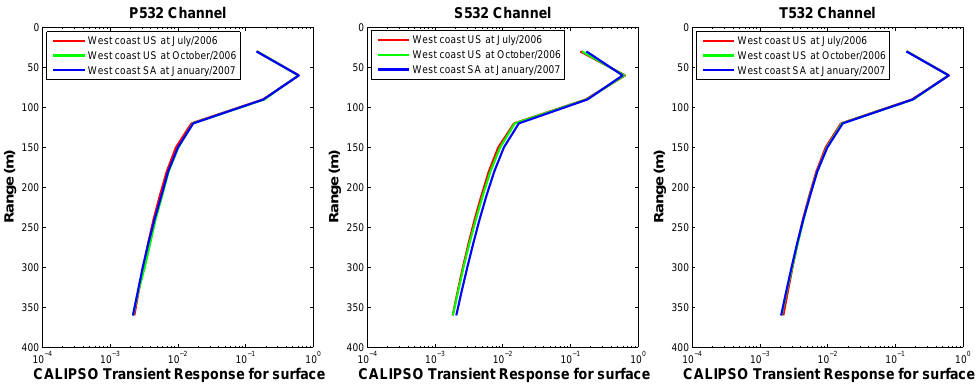
Fig. 2. Transient response of CALIOP derived from the land surface return at different months and different regions for three channels.